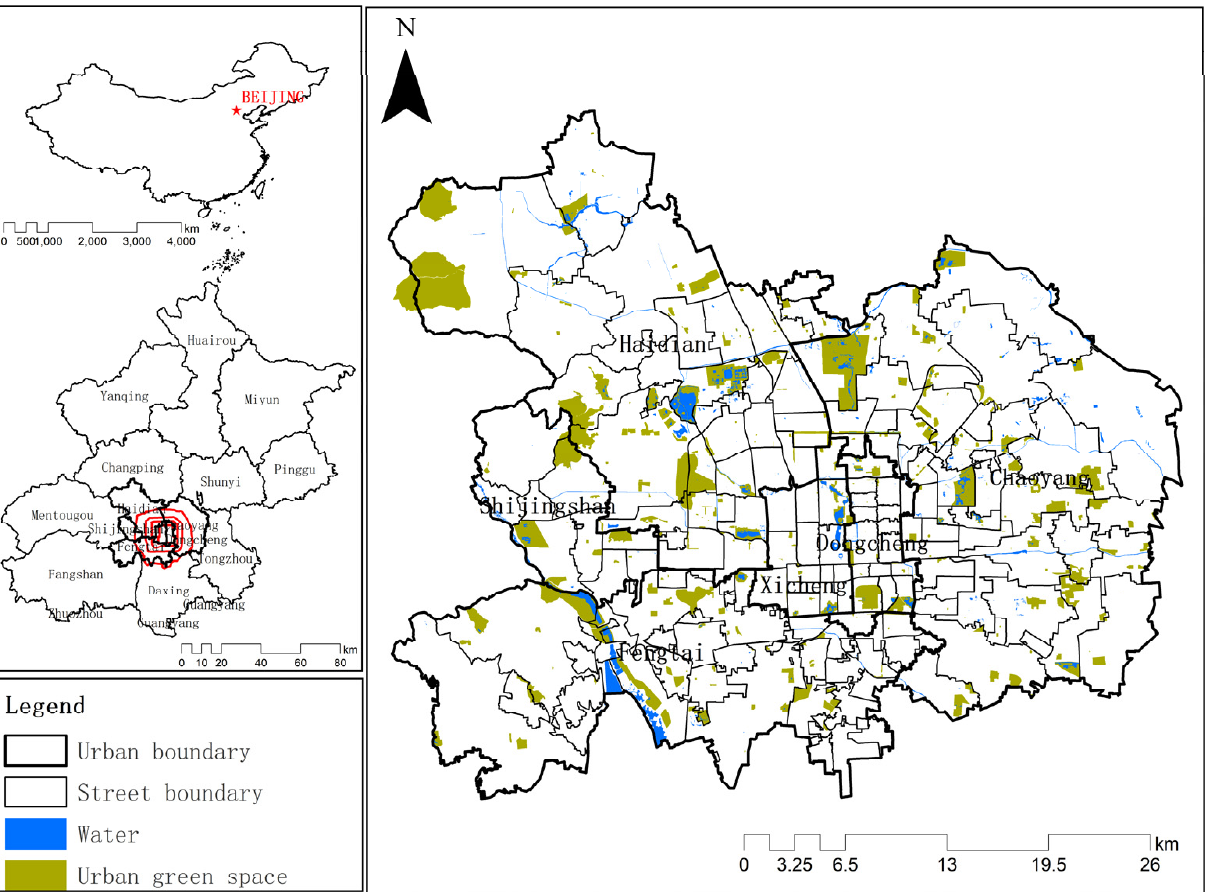
Figure 2. Study area.